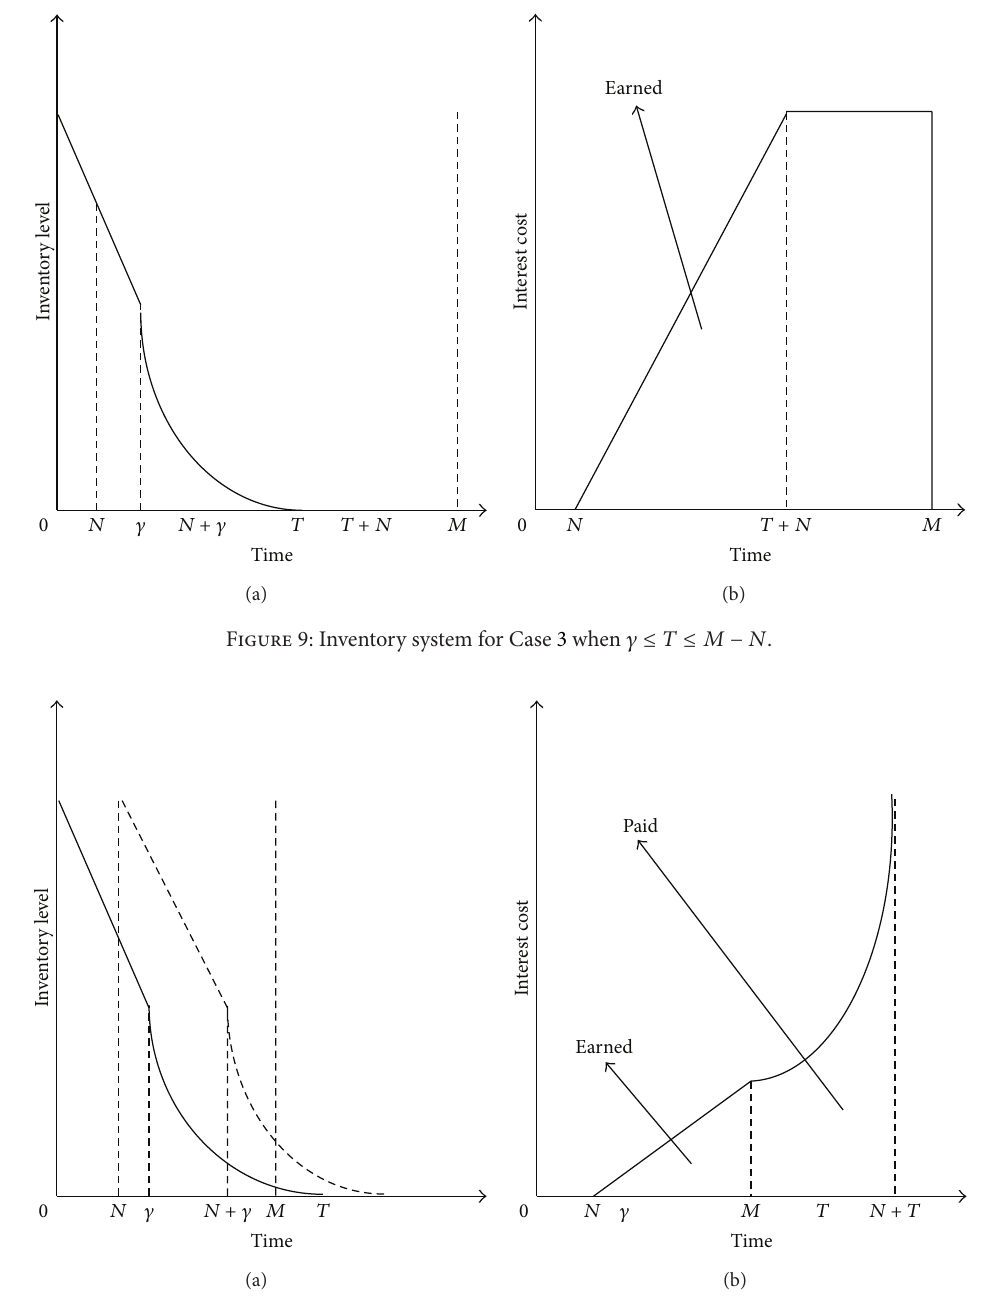
Figure 10: Inventory system for Case 3 when 𝑇 ≥ 𝑀 − 𝑁